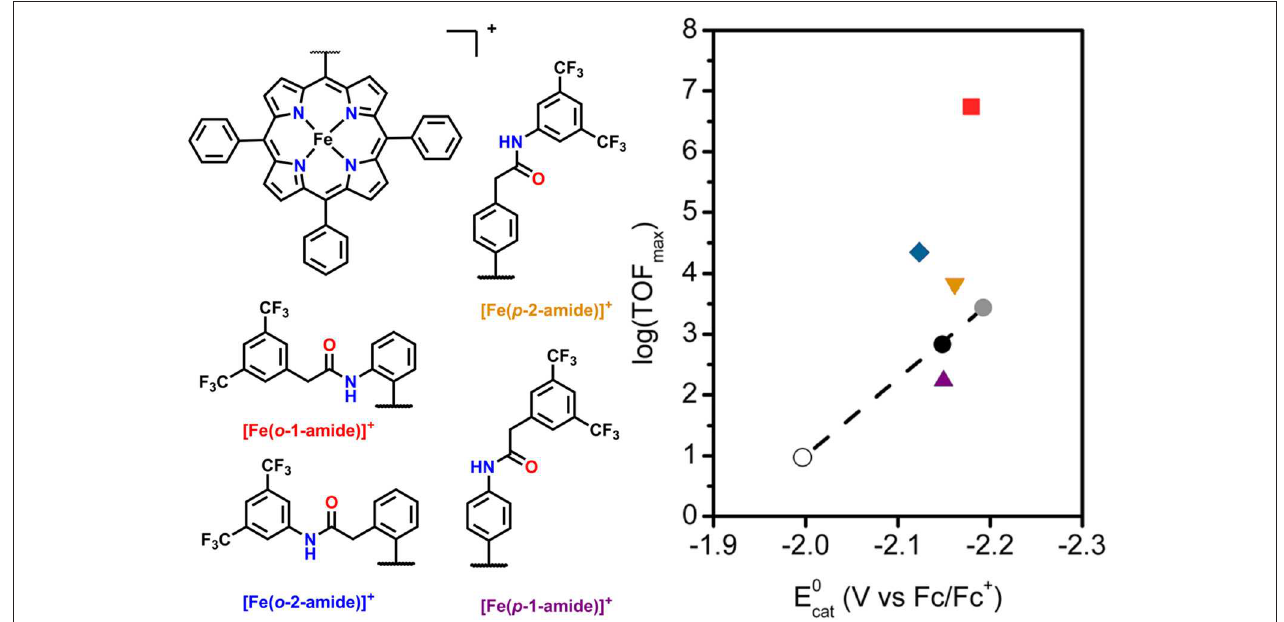
FIGURE 5 | Plot of log(TOF max ) vs. E 0 cat for mono-functionalized porphyrins used to study positional dependence of catalytic enhancement for this system. Circles are [Fe(TPP)] + derivatives which utilize electronic substitution of the phenyl rings for modulation of the redox potential of the Fe I / 0 couple. The upward purple triangle is [Fe( p -1-amide-TPP)] + , the downward orange triangle is [Fe( p -2-amide-TPP)] + , the blue diamond is [Fe( o -1–amide-TPP)] + , and the red square is [Fe( o -2-amide-TPP)] + . Reprinted with permission from Nichols et al. (2018b) — published by the Royal Society of